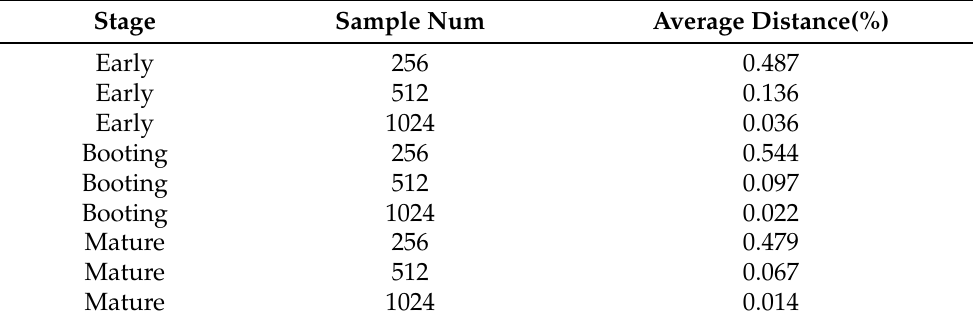
Table 3. Results of average distance with different numbers of sampling points: the smaller the value of average distance, the more stable the model.